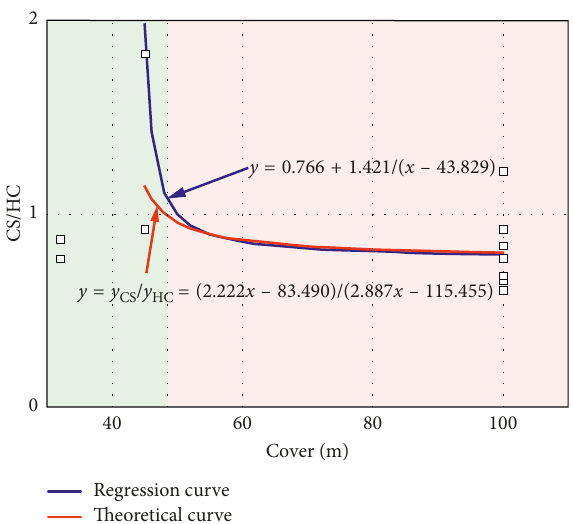
Figure 12: Comparison between theoretical curve and regression curve on relation of CS/HC with cover depth at 12.26m span. The graph of equation (7) was regarded as the theoretical curve, and the graph of equation (8) was regarded as the regression curve.